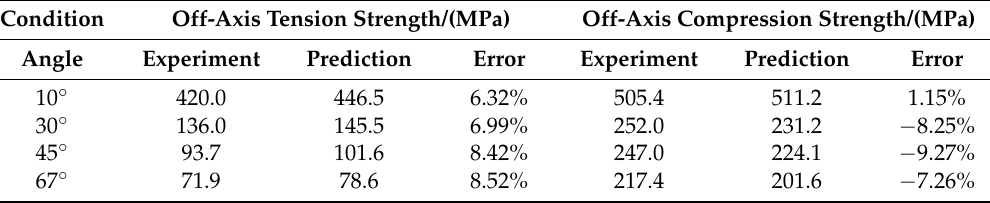
Figure 5. Failure modes in the simulations: ( a ) Off-axis tension; ( b ) Off-axis compression. Table 3. Strength of unidirectional laminates T300/5228A under off-axis loading.